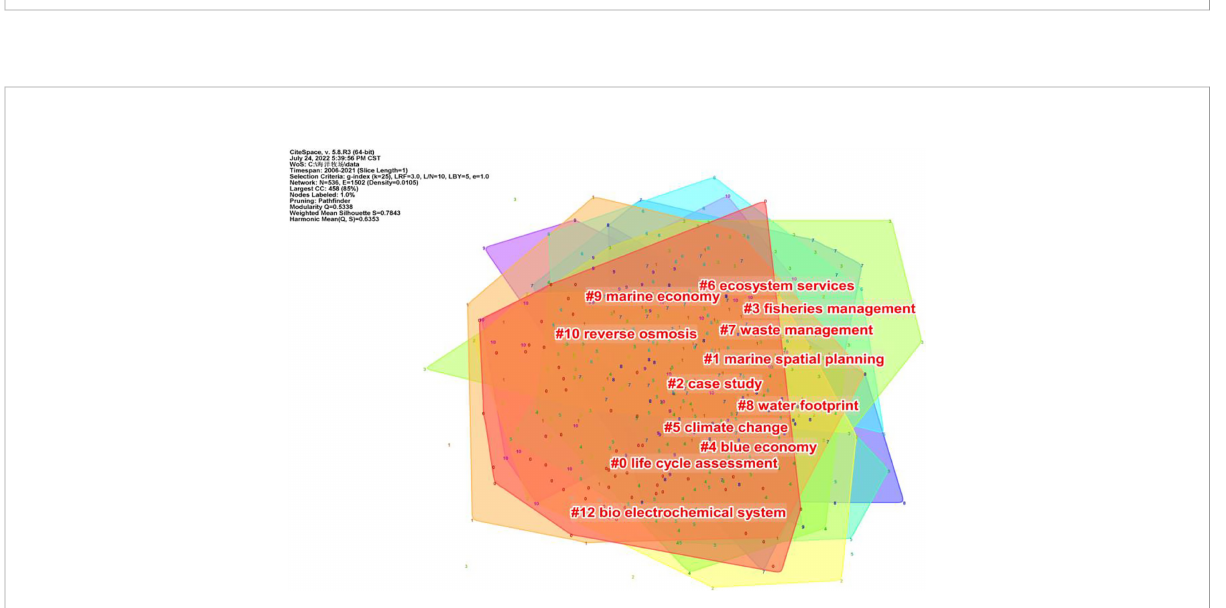
FIGURE 4 Keyword hotspot analysis knowledge graph.